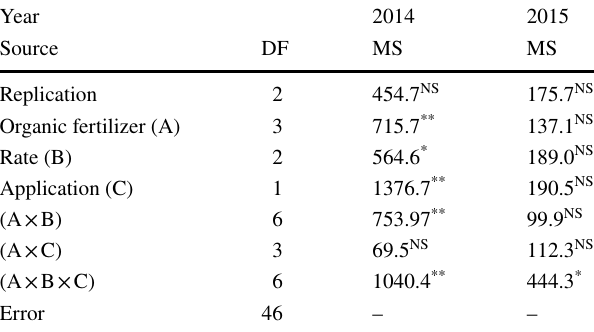
Table 3 Mean square of tomato yield for different factors in the growing seasons of 2014–15